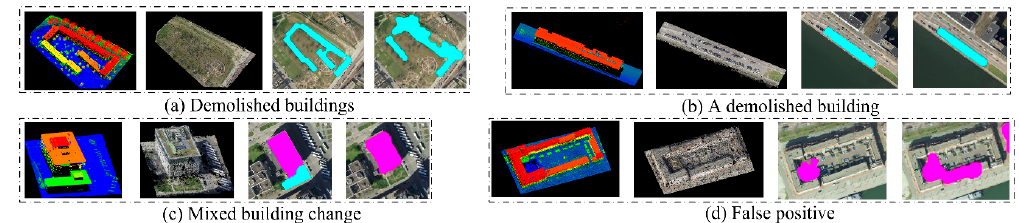
Figure 10. Four examples of the change detection results for Rotterdam data.